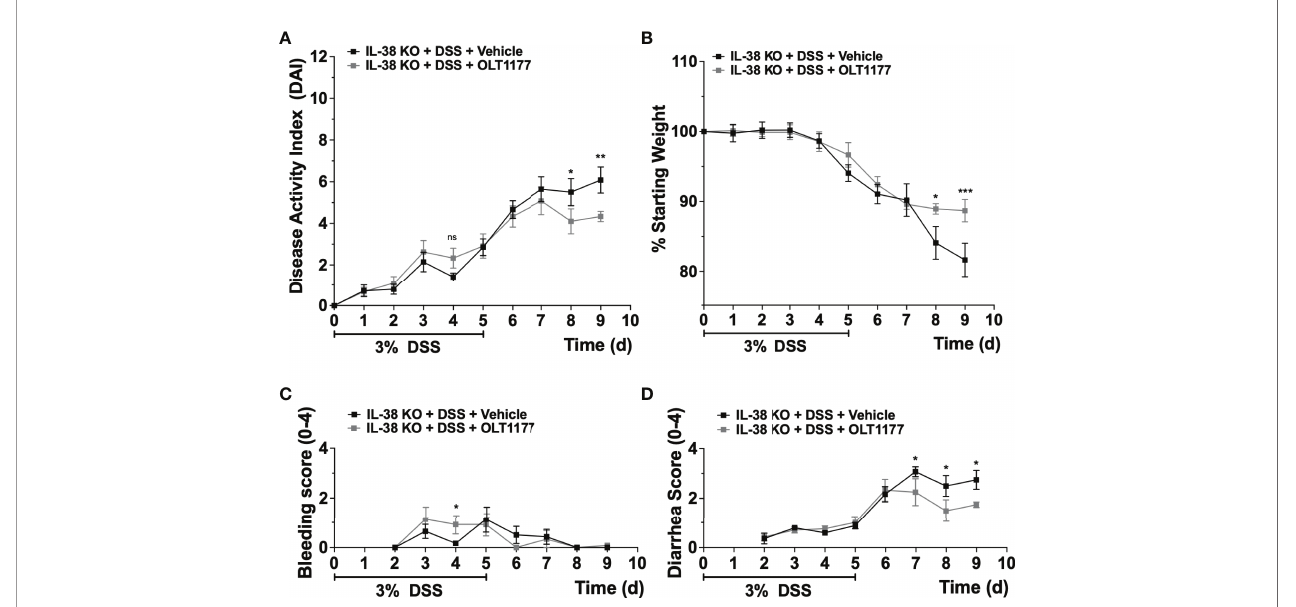
FIGURE 5 | NLRP3 inhibition enhances recovery in IL-38 de fi cient mice. IL-38 de fi cient mice were subjected to DSS and treated daily i.p. with 200 mg/kg OLT1177, an NLRP3 inhibitor, or vehicle (N = 7 per group). (A) DAI scores, maximum DAI is 12. (B) Weight loss, maximum loss is 20%. (C) Bleeding score, maximum score is 4. (D) Diarrhea score, maximum score is 4. Data were pooled from 2 separate experiments with 3-4 mice each. The data represents the mean ± SEM, *P < 0.05, **P < 0.01, ***P < 0.001, by two-way ANOVA with Fisher ’ s multiple comparison. Ns: not signi fi